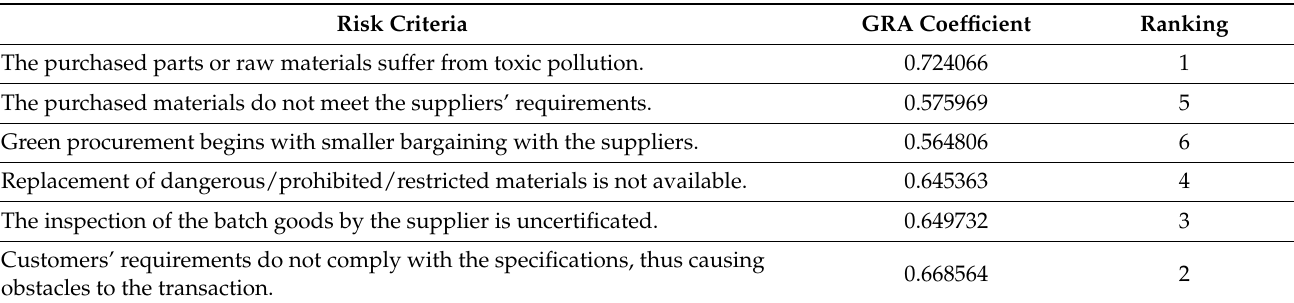
Table 6. The ranking of the green criteria in green procurement.